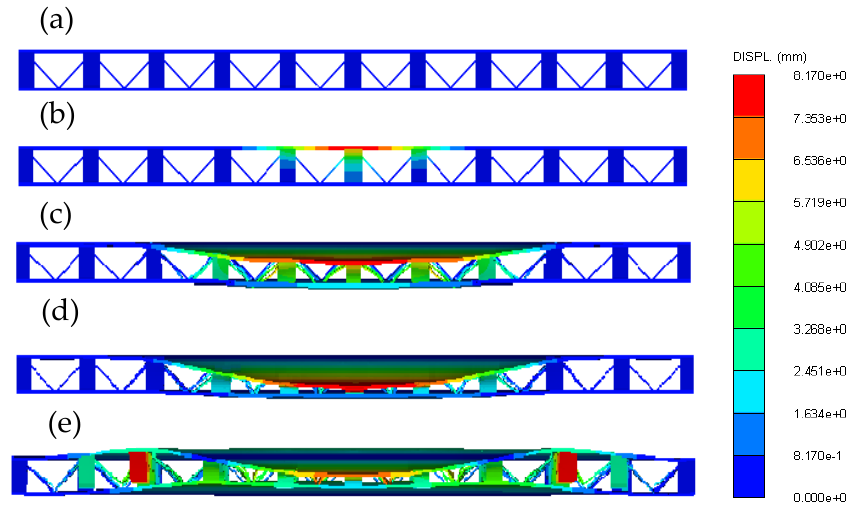
Figure 6. Dynamic response of the TZRC.